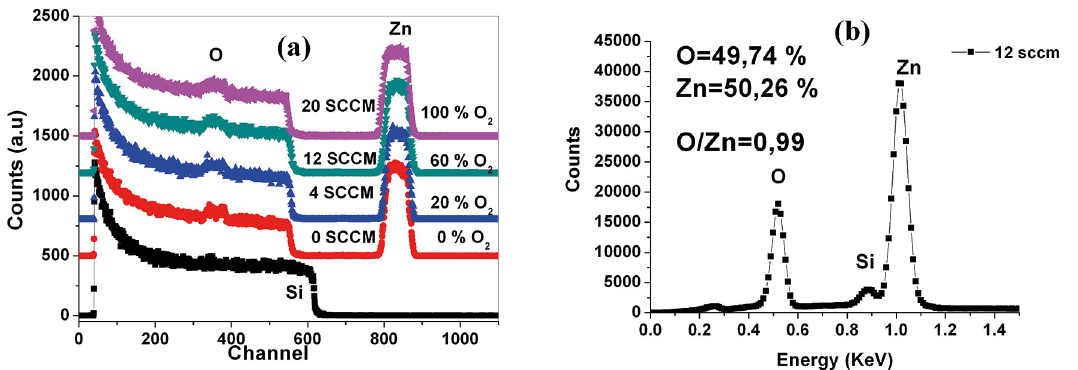
Figure 2: (a) RBS spectra of ZnO/Si at different oxygen flow and (b) Atomic composition by EDX characterization for ZnO/Si film at 12 sccm Table 2: Atomic percentage for ZnO film for different oxygen flow Atomic